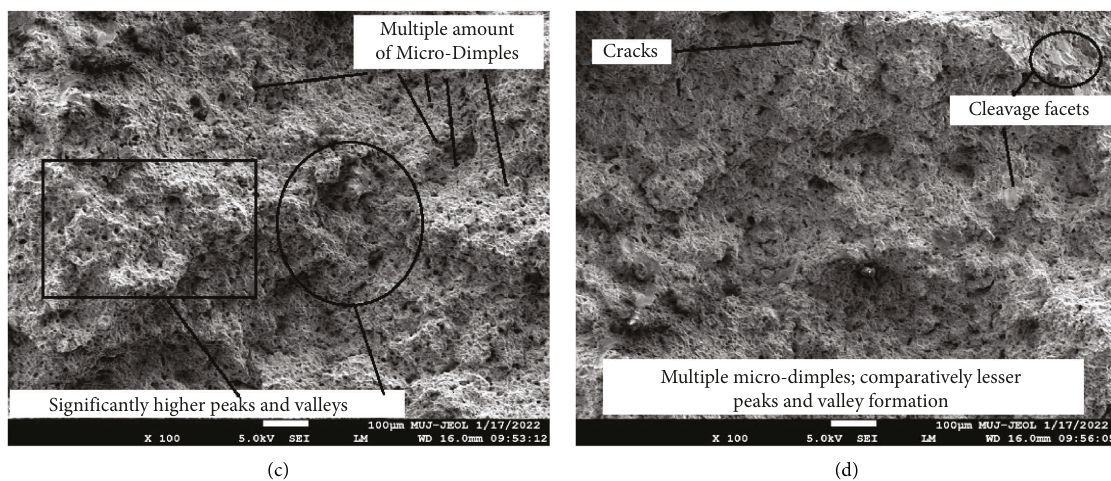
Figure 5: Fractographic analysis of specimens broken though tensile test. Observation into (a) water-quenched specimen, (b) oil-quenched specimen, (c) sand-cooled specimen, and (d) air-cooled specimen.